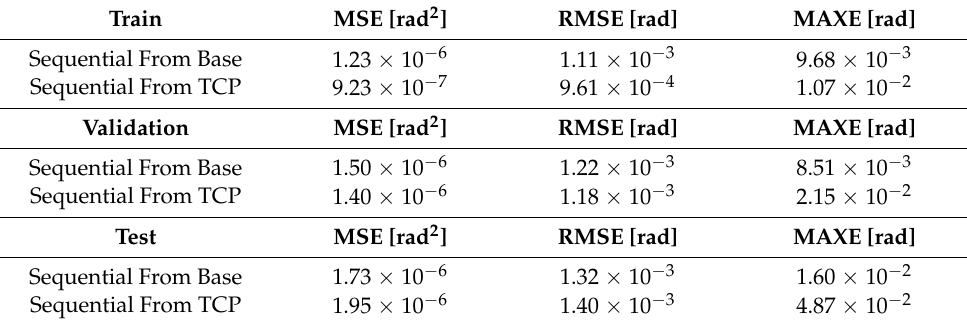
Table 6. Train, validation, and test performance for the sequential models. Train Sequential From